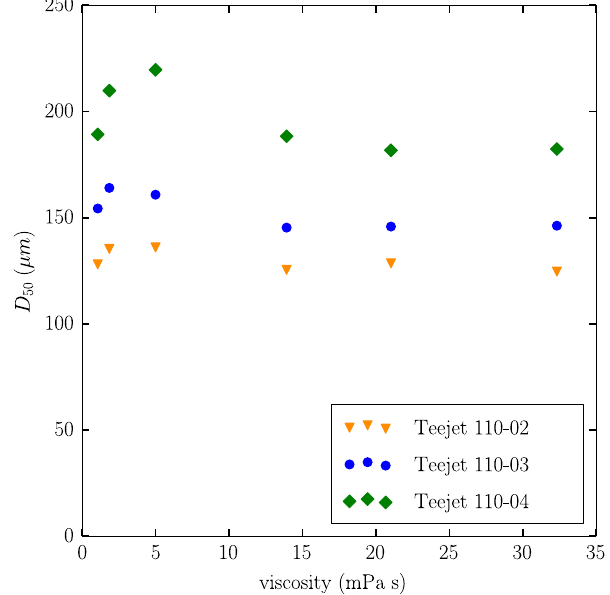
FIG. 16. Median droplet size versus viscosity for three different nozzles. There seems to be no dependency on viscosity for this